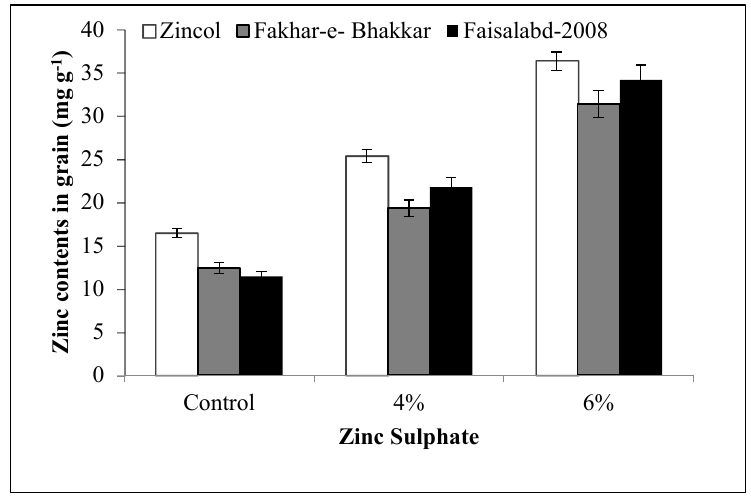
Figure 4. Interactive effect of varieties × zinc sulphates on the grain zinc contents of bread wheat grains grown under a semi ‐ arid environment. Error bars represent the standard error (n = 5).